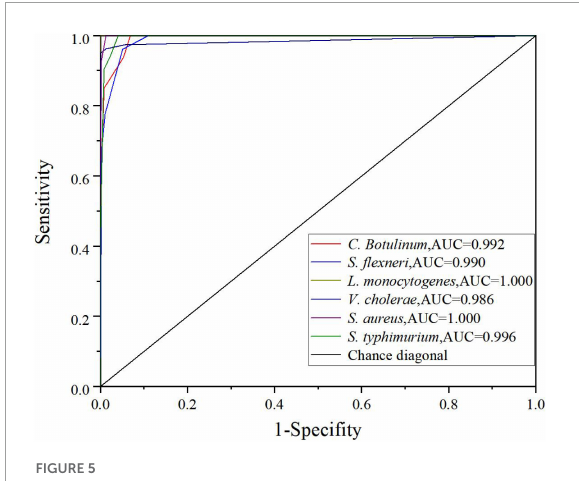
FIGURE5 ROC curve of the DT model using the SG 1st Der.